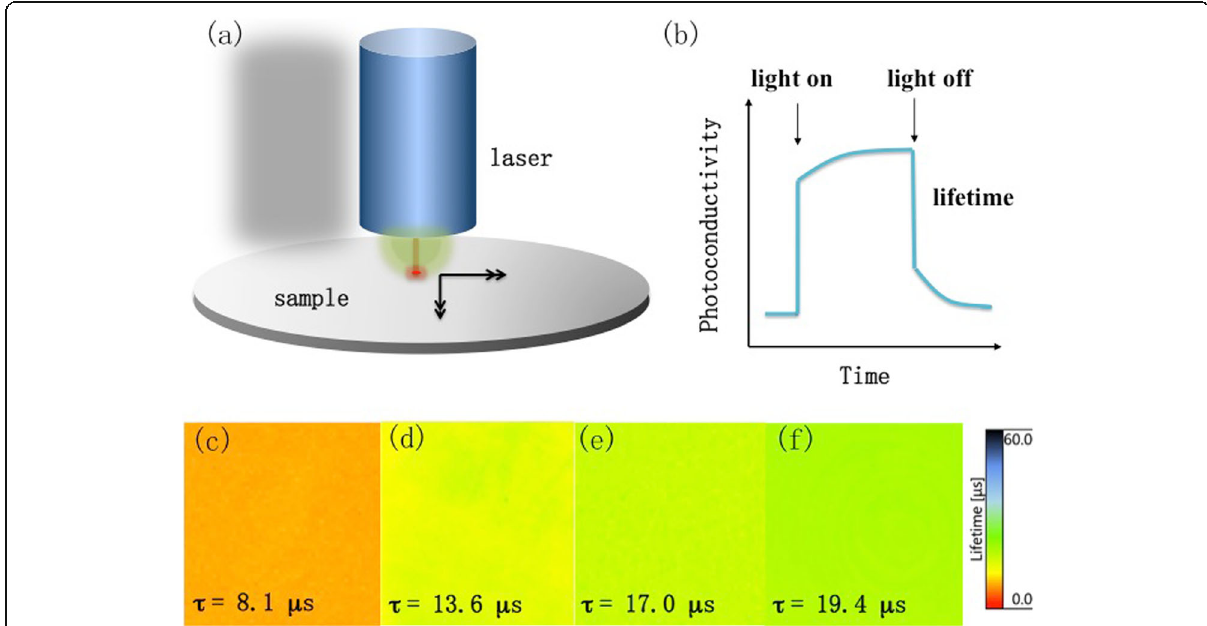
Fig. 3 Minority charge carrier lifetime mapping for different Si samples. The schematic diagram of minority charge carrier lifetime: a the measurement instruction and b the mechanism of carrier lifetime measurement: the photoconductivity, which is closely related to the carrier concentration, is measured by microwave absorption during and after the excitation with a rectangular laser pulse. c Si NW without TMAH treatment; Si NW with TMAH treatment for d 50, e 60, and f 70 s. The size of each image was 1.5 × 1.5 cm 2